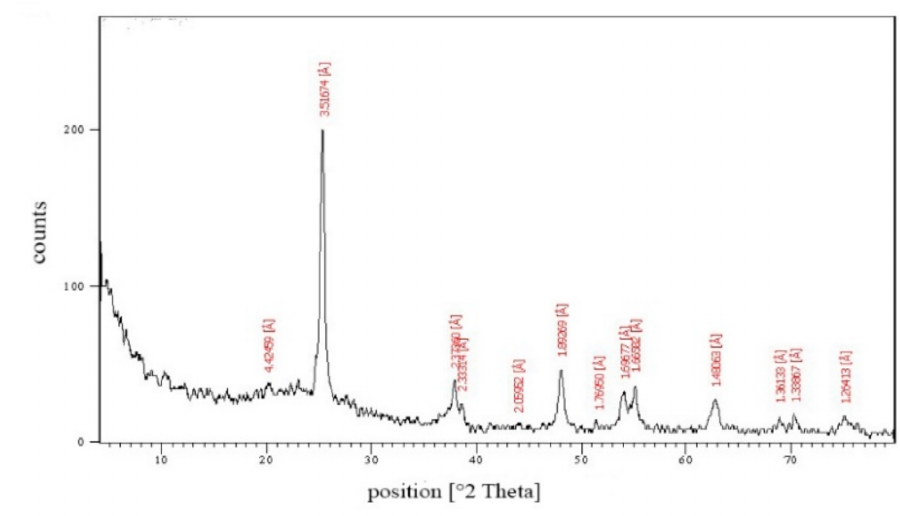
Figure 2. X-ray diffraction pattern of TiSiO 4 NPs.